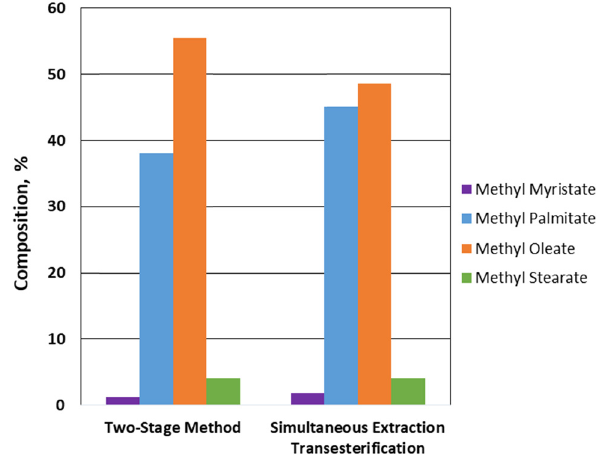
Figure 3: Major FAME composition of biodiesel generated by two - stage method and simultaneous extraction transesteri fi